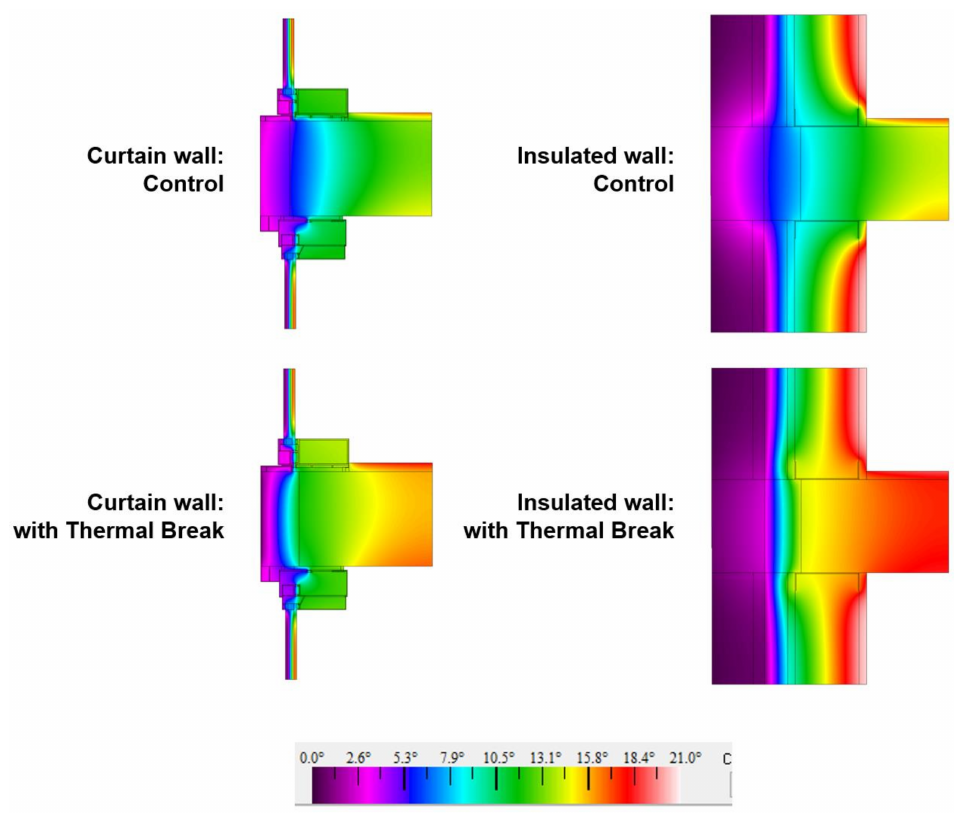
Figure 11. Color gradient of temperature distributions for the di ff erent balcony connection options and the installed thermal break